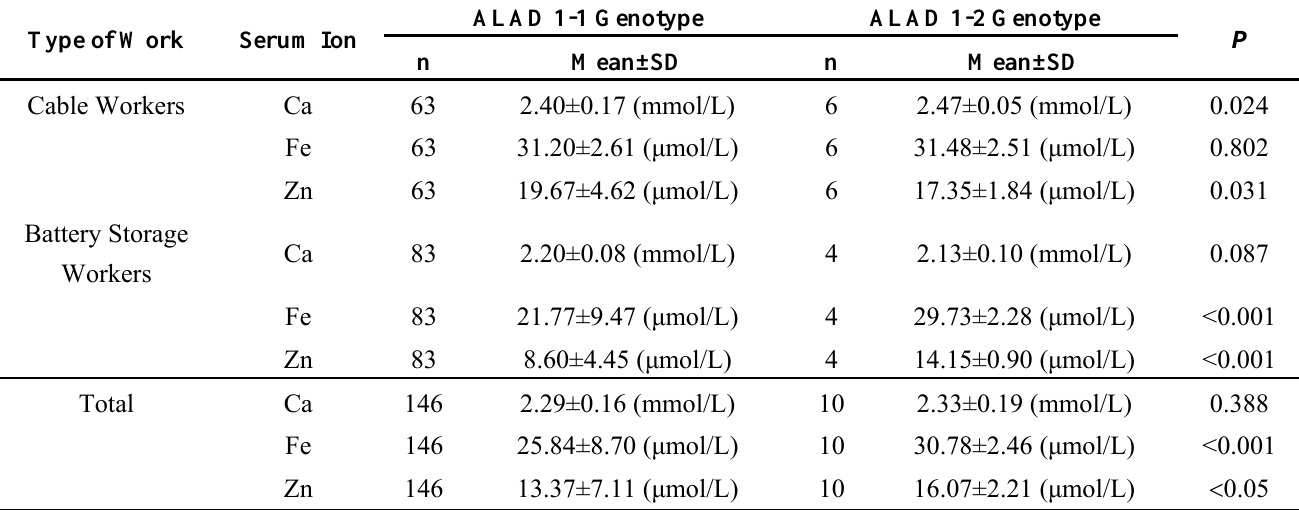
Table 4. Serum calcium, iron, and zinc levels by genotypes.